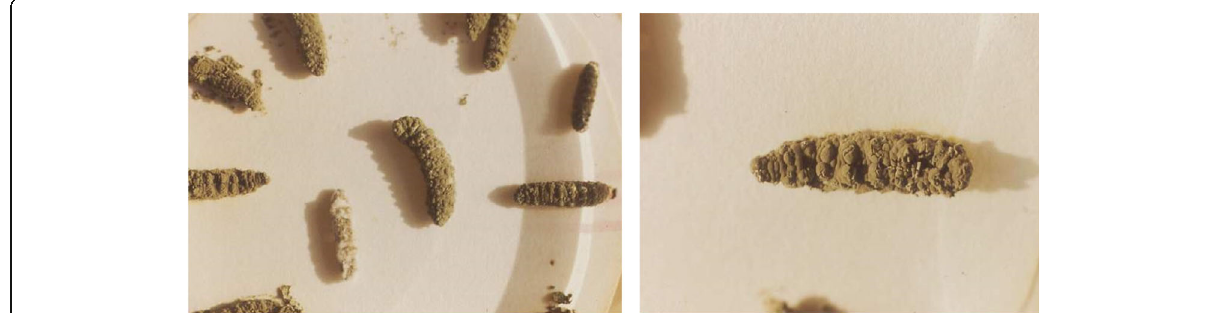
Fig. 1 Cadavers of Spodoptera littoralis larvae covered with the dark green mycelium and spores proving death with Metarhizium anisopliae (Green Muscardine) in the efficacy